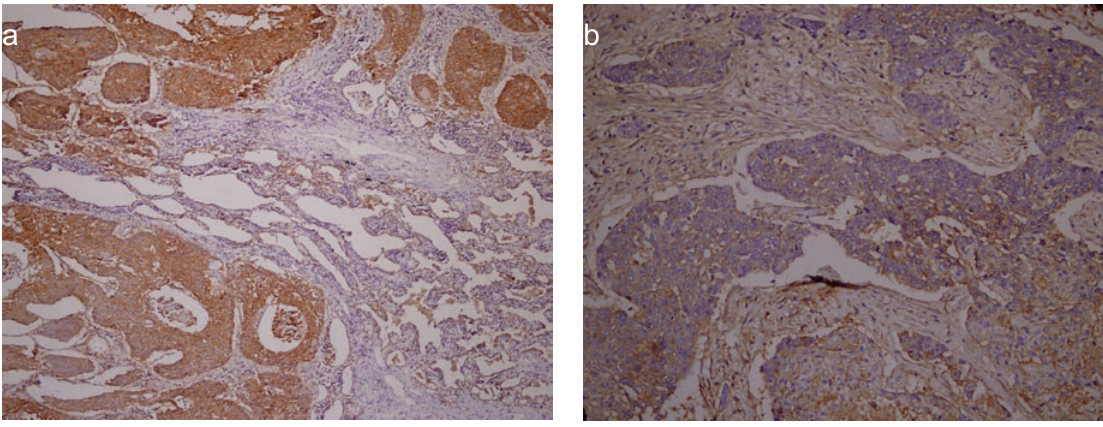
Figure 4. EMMPRIN staining in adenocarcinoma (Strong (4a), moderate (4b), weak (4c) and negative (4d) staining, DAB, 4a-4b x200; 4c-4d x100).